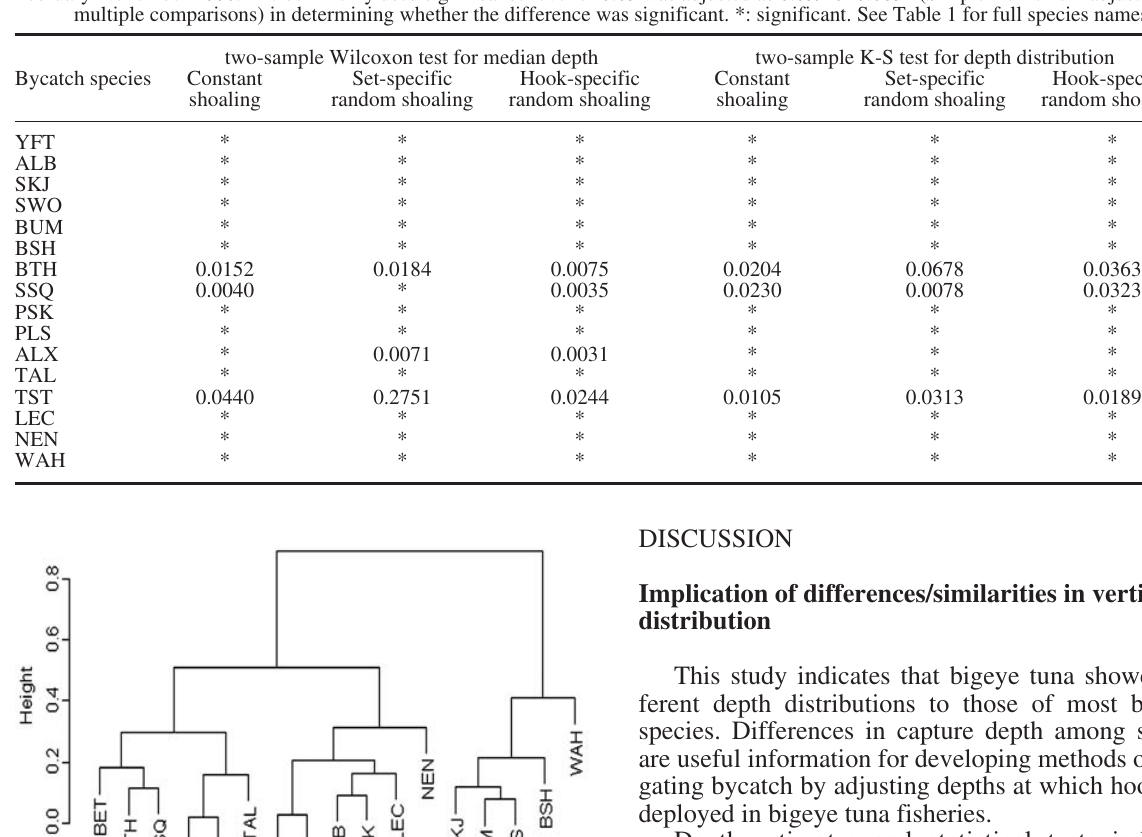
Table 3. – The observed P values for testing the difference in median depth and in depth distribution (estimated from constant and random shoaling assumptions) between bycatch species and bigeye tuna captured in the longline observer trip in the central-eastern Pacific Ocean in